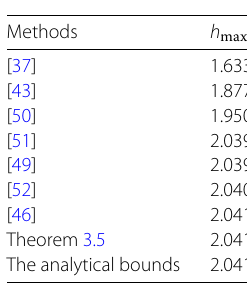
Table 5 Upper bound on h obtained for Example 4.5